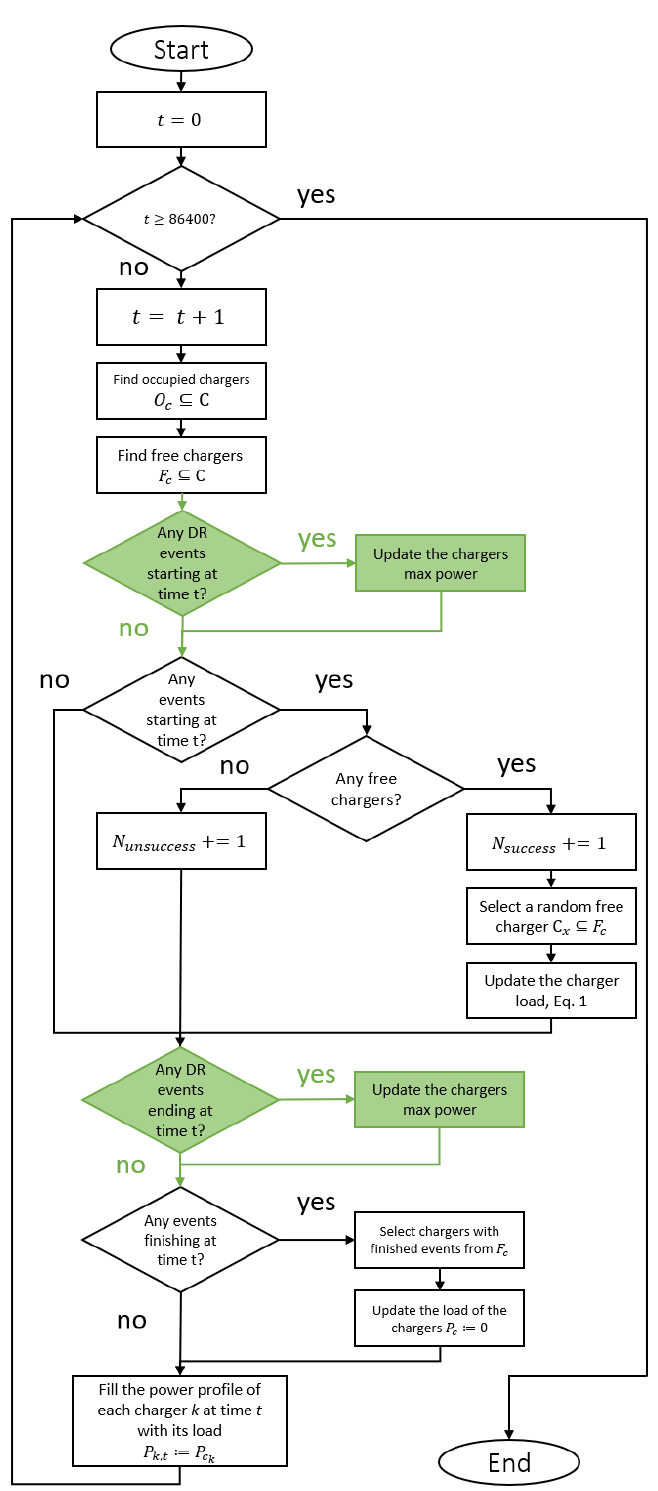
Figure 7. Schematic representation of the simulation algorithm with inclusion of DR events. Additions to Figure 5 are highlighted in